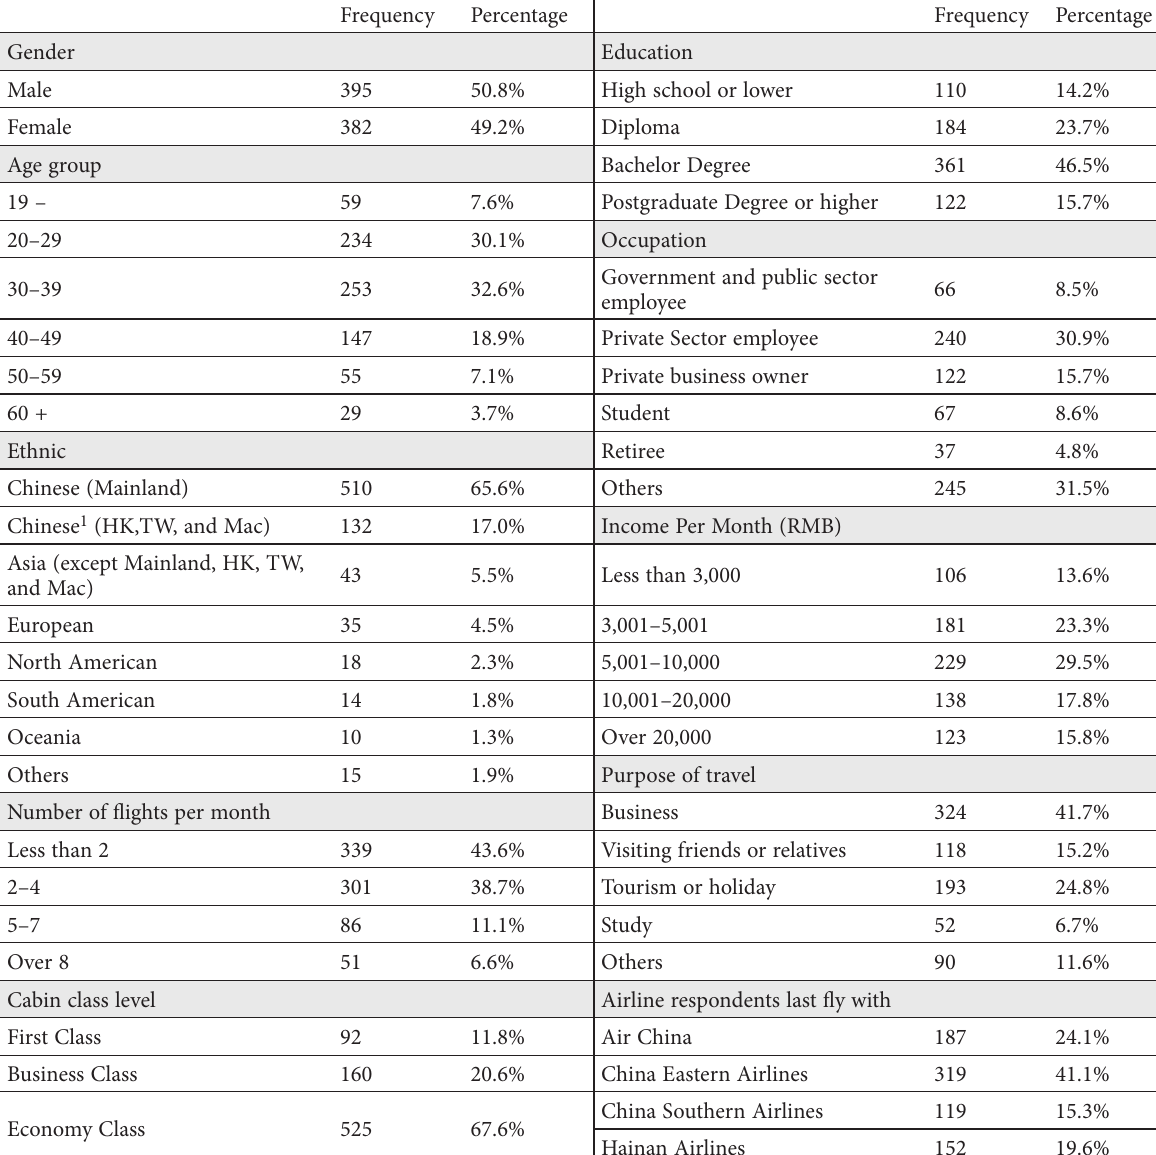
Table 1. Demographic characteristics of the study’s